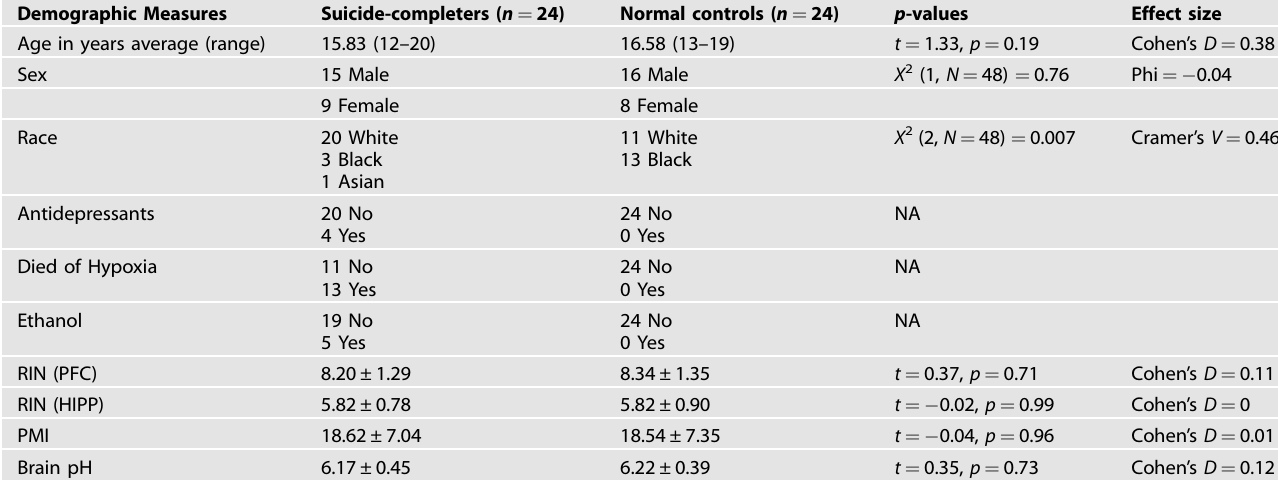
Table 1. Teenage cohort demographic and statistical measures.